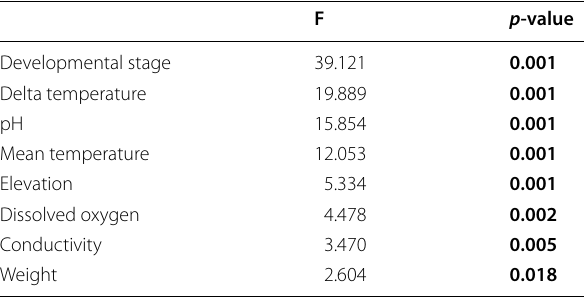
Table 3 Permutational like ANOVA results of each variable introduced in the dbRDA regression